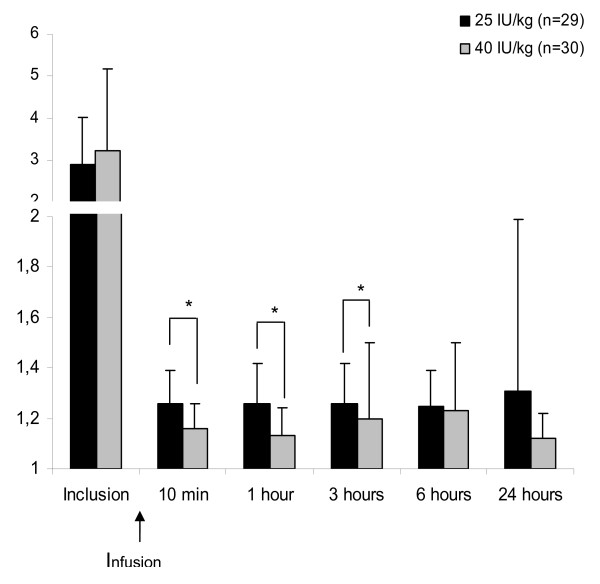
Changes in mean INR values after 4-factor PCC infusion in 25 and 40 IU/kg groups. *Significant difference with P <0.05. All patients were present during the 24 h. At inclusion, INR was calculated for 29 patients in the 25 IU/kg group and 30 patients in the 40 IU/kg group, at 10 min in 27 and 29, at 1 h in 26 and 28, at 3 h in 28 and 30, and at 24 h in 22 and 30, respectively. INR, international normalised ratio; PCC, prothrombin complex concentrate.